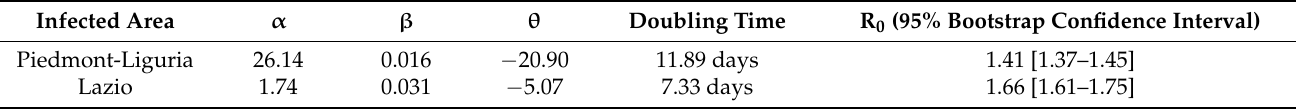
Table 2. Estimated exponential model